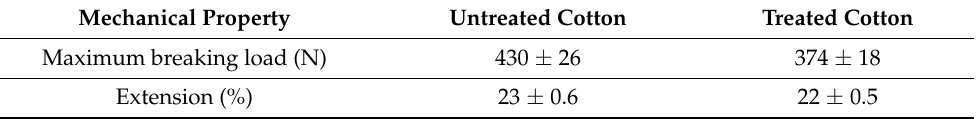
Table 1. Mechanical properties.